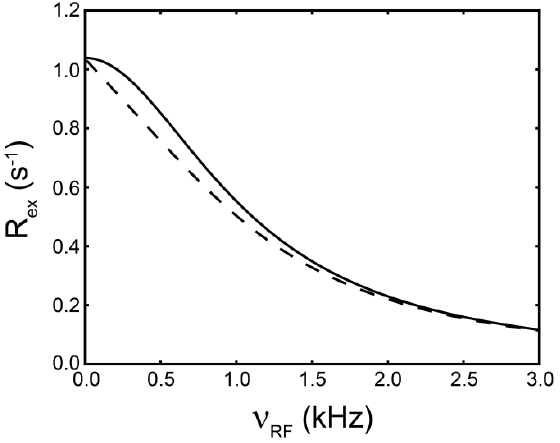
Figure 3. Dependence of R (dashed black line) experiments. The dashed black line was created using the Carver-Richards model [181] which is applicable for CPMG experiments, and the solid black curve calculated using Equation (44). The exchange parameters τ 150  s, 5 %, and 61 Hz,